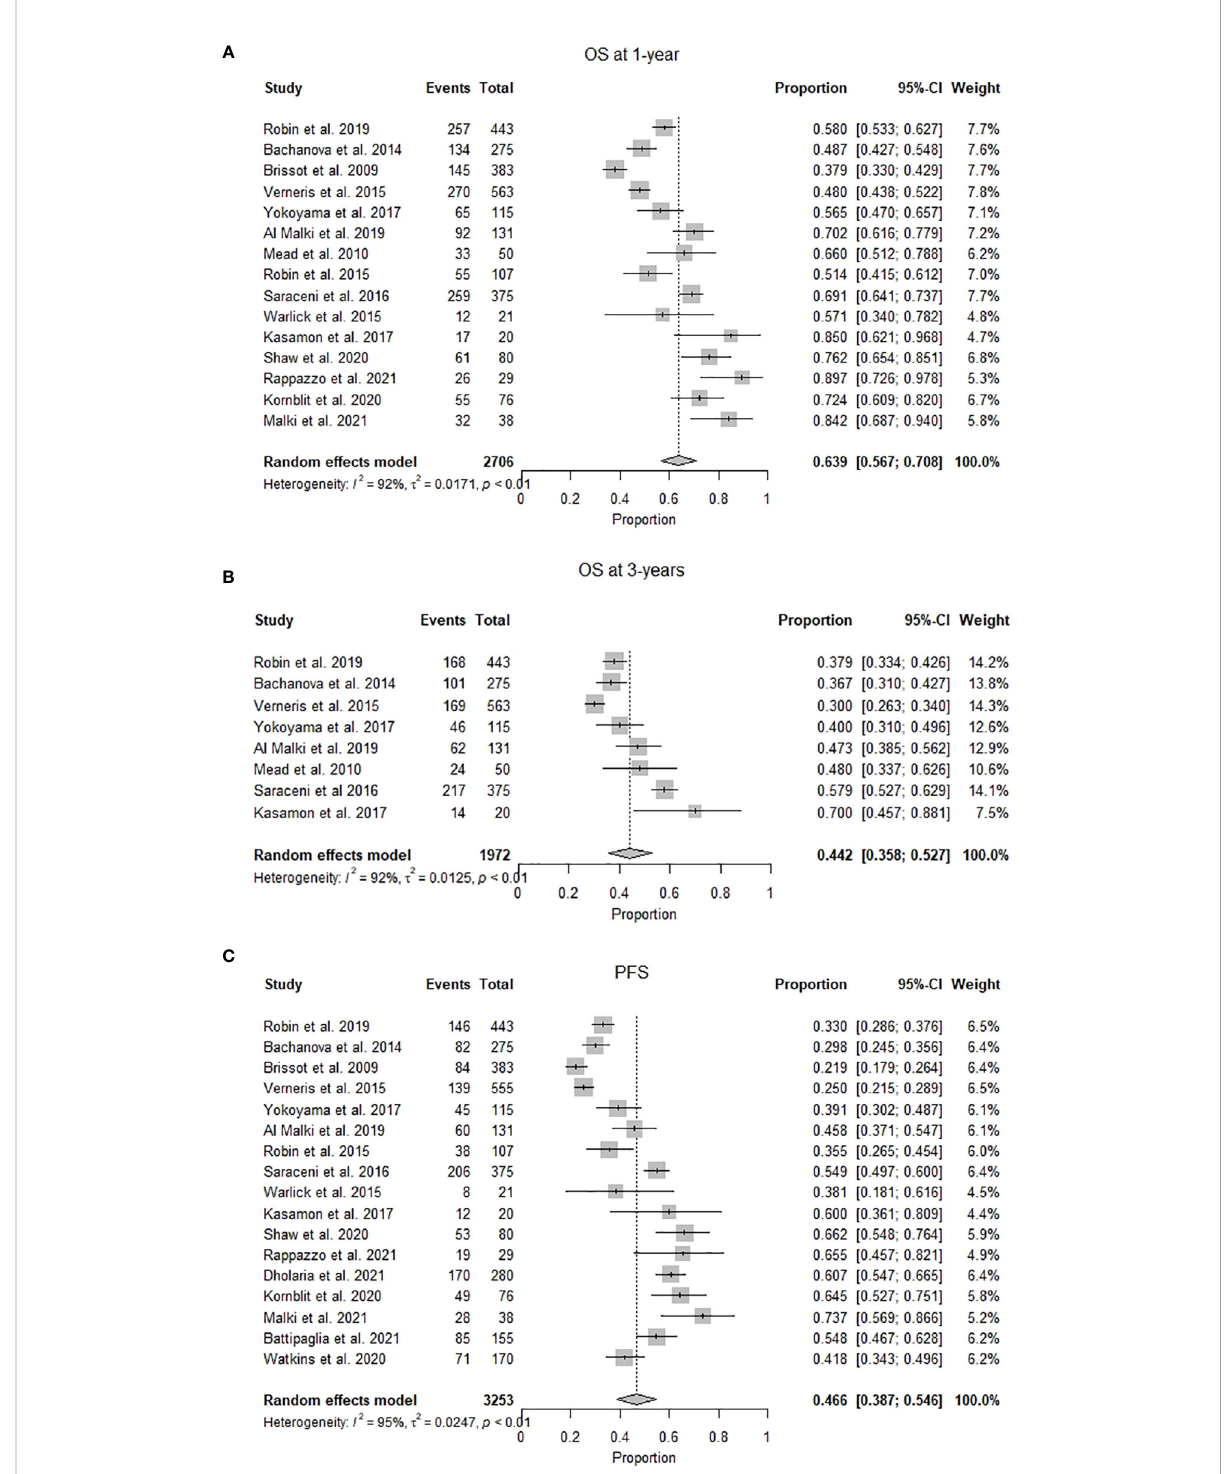
FIGURE 2 (A) Forest plot of pooled 1-year overall survival after mismatched unrelated donor allogeneic stem cell transplant (n=2706). (B) Forest plot of pooled 3-year overall survival after mismatched unrelated donor allogeneic stem cell transplant (n=1972). (C) Forest plot of pooled progression- free survival after mismatched unrelated donor allogeneic stem cell transplant